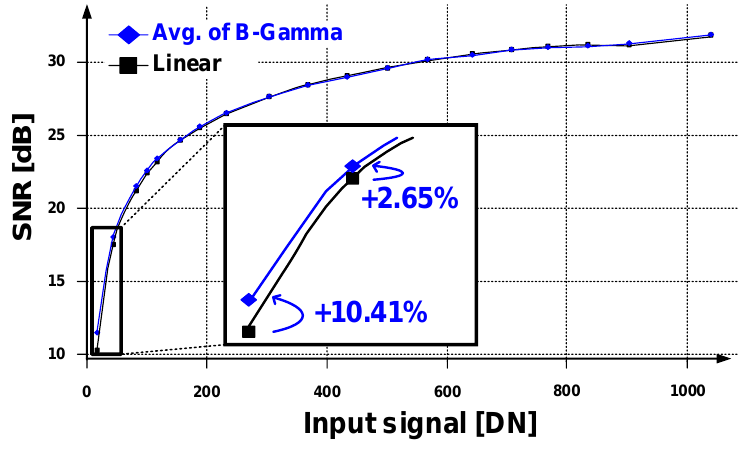
Figure 9. Measured SNR graph of the prototype CIS. The figure of merit (FoM) defined in [13] was used for comparison with other state-of- the-art sensors. The FoM defined in [13] was used for comparison.